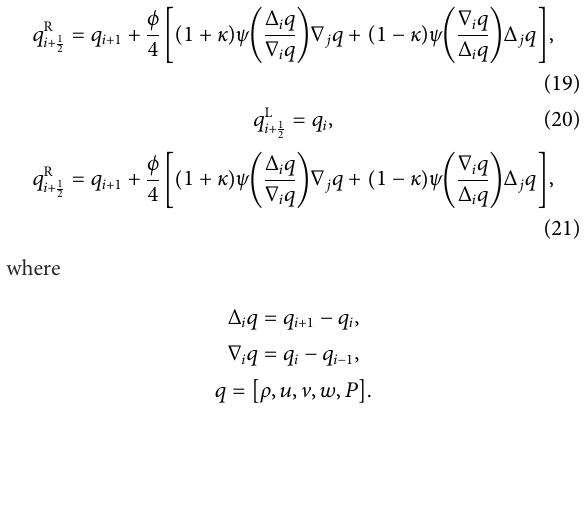
FIGURE 8 Non-uniform mesh used for transonic fl ow over a bump in a channel of size (192 × 64) in x and y directions, respectively (alternate grid lines are shown in both directions for clarity); IB shown by the yellow line.